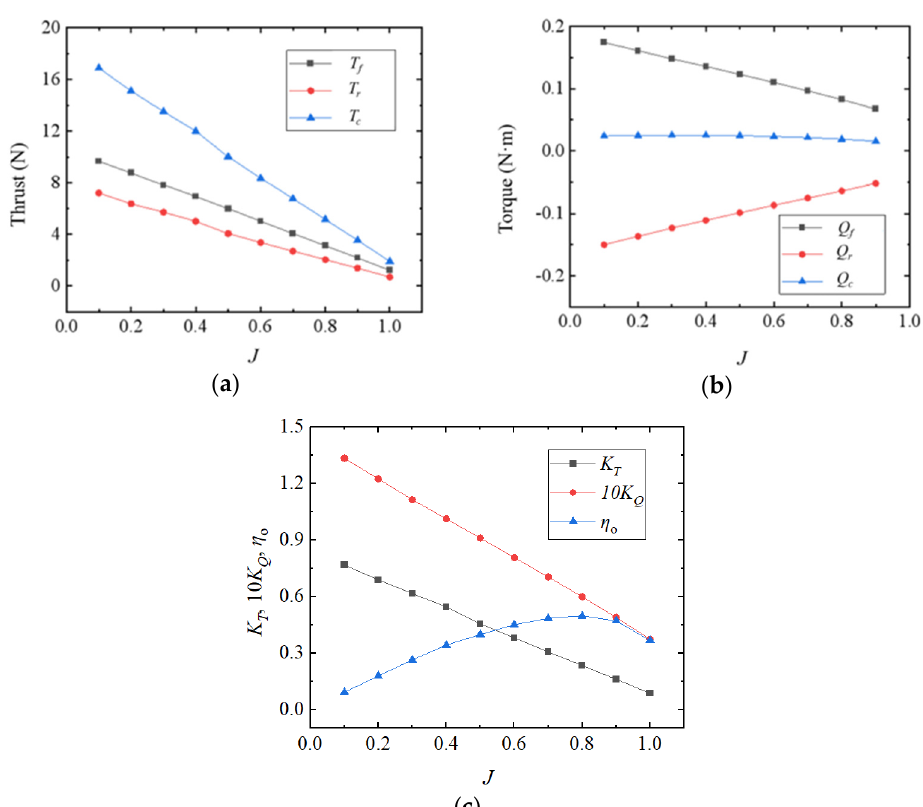
Figure 22. The open water performance of the CRP in terms of the thrust output ( a ), the torque output ( b ), and the dimensionless K - J parameters ( c ) (subscript f : front propeller; r : rear propeller; c : counter rotating propeller).